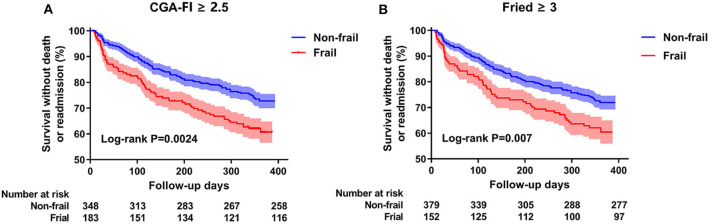
Kaplan-Meier survival curves by frailty in all participants. (A) stands for the frailty defined by CGA-Fl. (B) represents the frailty defined by Fried frailty phenotype. Event rates of 1-year death or readmission have been analyzed by a log-rank test.